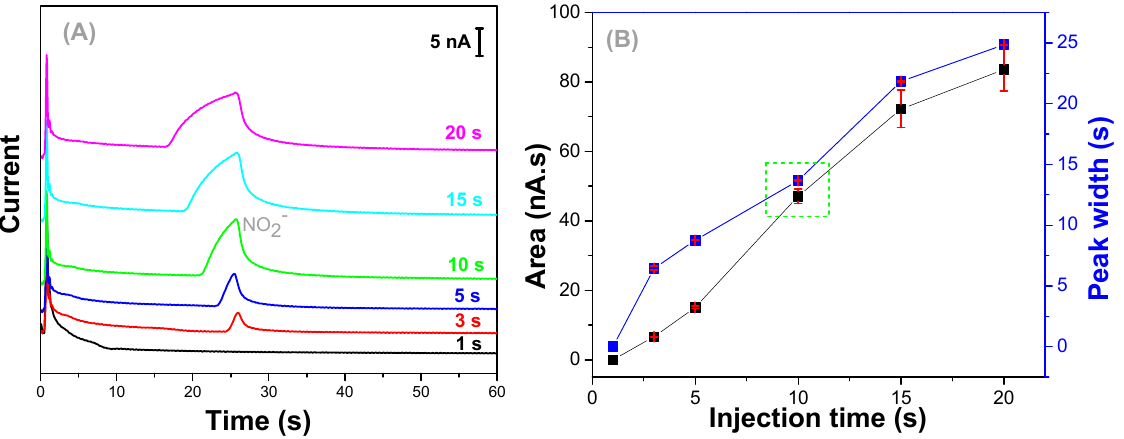
Figure 3. ( A ) Electropherograms showing the separation and detection of nitrite (50 μ mol L − 1 ) introduced into microchannels under different injection times: 1–20 s. ( B ) Area and peak width versus injection time. Running buffer: 30/15 mmol L − 1 Lactic Acid/Histidine (pH = 3.8). Injection: − 800 V, Separation: − 1000 V for 60 s, Detection 0.7 V versus